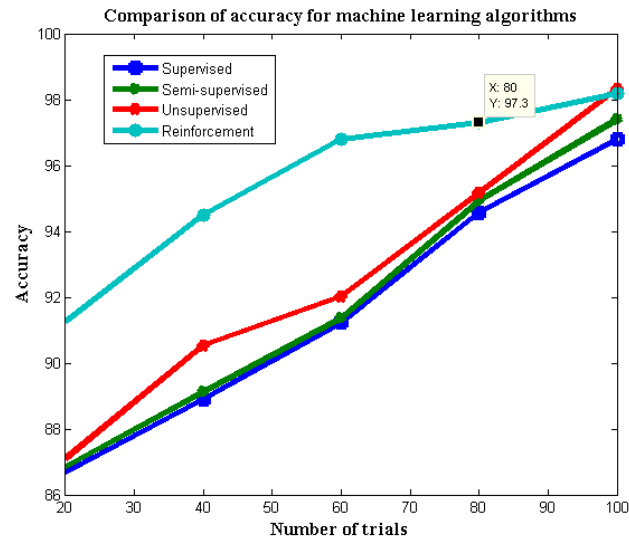
Figure 7. Accuracy of machine learning algorithms.